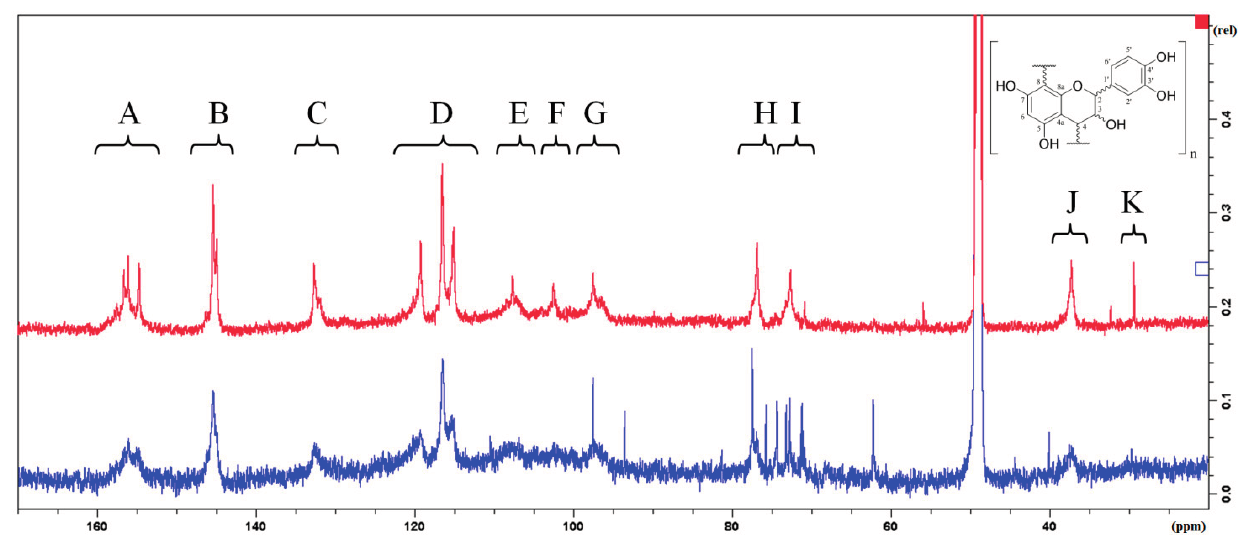
Figure 2. 13 C-NMR of the “regular” (upper) and the “unusual” (lower) PAs. A (152–160 ppm): C-5, C-7, C-8a; B (144–147 ppm): C-3 ′ , C-4 ′ ; C (131–134 ppm): C-1 ′ ; D (114–123 ppm): C-2 ′ , C-5 ′ , C-6 ′ ; E (106–110 ppm): substituted C-6 and C-8; F (101–104 ppm): C-4a; G (95–99 ppm): unsubstituted C-6 and C-8; H (76–78 ppm): C-2; I (71–74 ppm): C-3; J (36–39 ppm): C-4 of extender units; K (29–30 ppm): C-4 of terminal